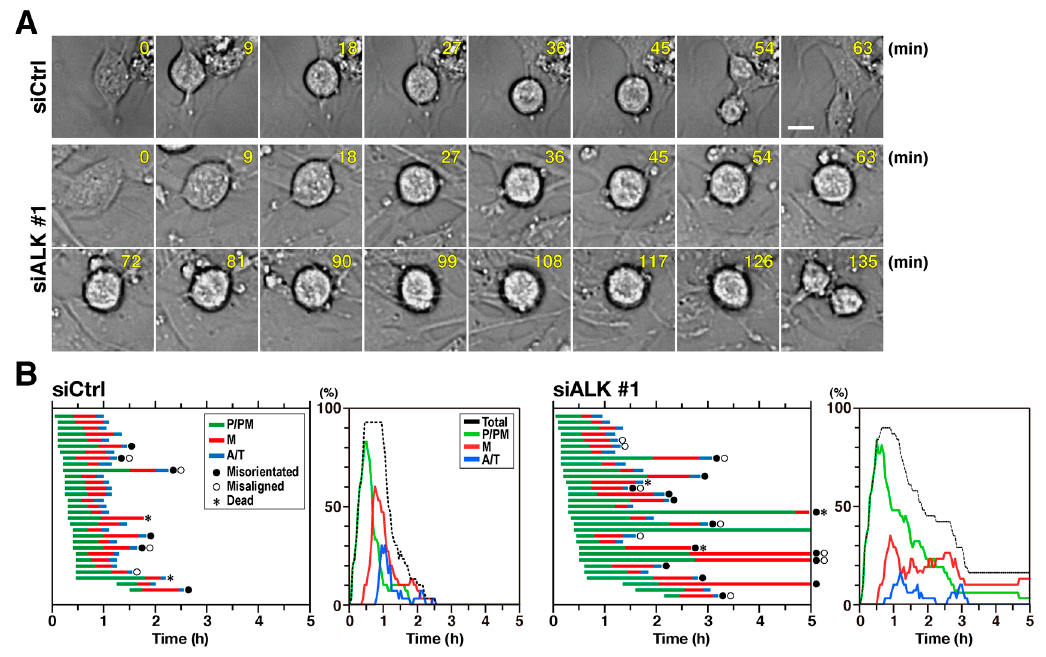
Figure 4. ALK inhibition delays both prophase/prometaphase and metaphase. SH-SY5Y cells were transfected with ALK-targeting siRNA (siALK #1) or nontargeting siCtrl. At 52 h after siRNA transfection, cells were synchronized with 4 µM RO-3306 and mitotic progression was monitored every 3 min for 5 h by time-lapse imaging. ( A ) Representative images of siCtrl-transfected cells and ALK knockdown cells. Scale bar = 10 µm. ( B ) Duration of prophase and prometaphase (P/PM, green), metaphase (M, red), and anaphase and telophase (A/T, blue) for 30 individual control cells and 31 individual siALK–transfected cells, was measured as described in material and methods. Line graphs show percentages of total mitotic cells (black), cells in P/PM (green), M (red), and A/T (blue) plotted against time.